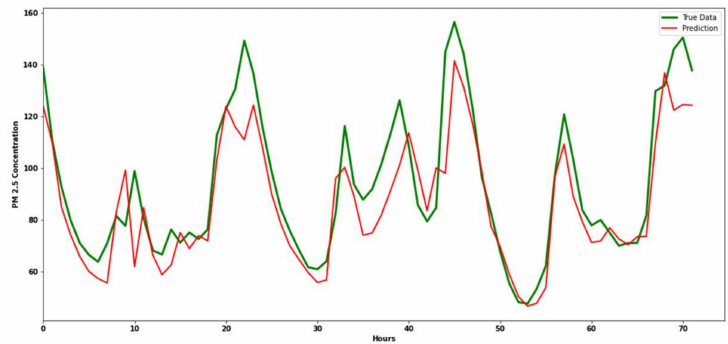
Figure 20. Forecasting for the next 72 h for Islamabad using the LSTM model.